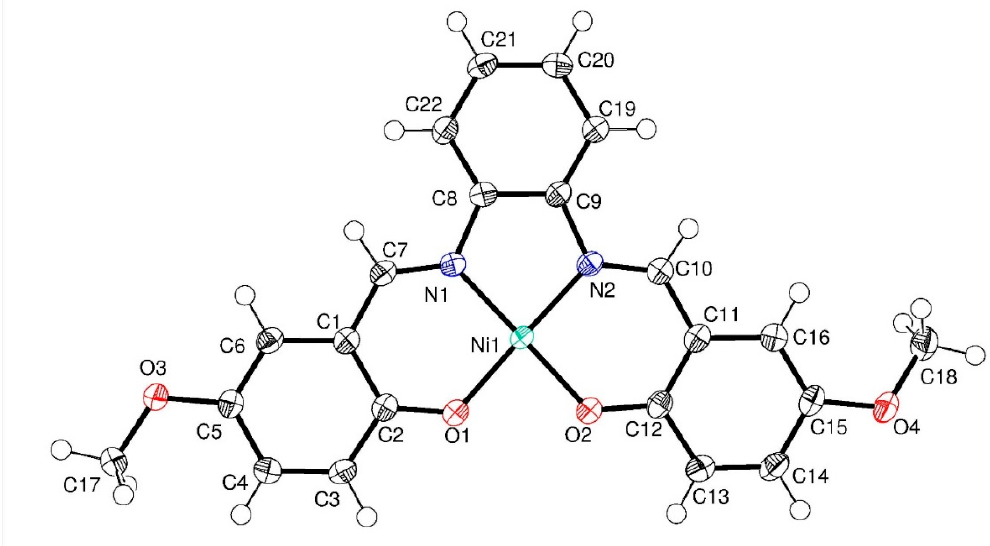
Figure 5. Perspective of the compound NiMeO salphen with a displacement ellipsoids at a 65% probability level for non-H atoms.